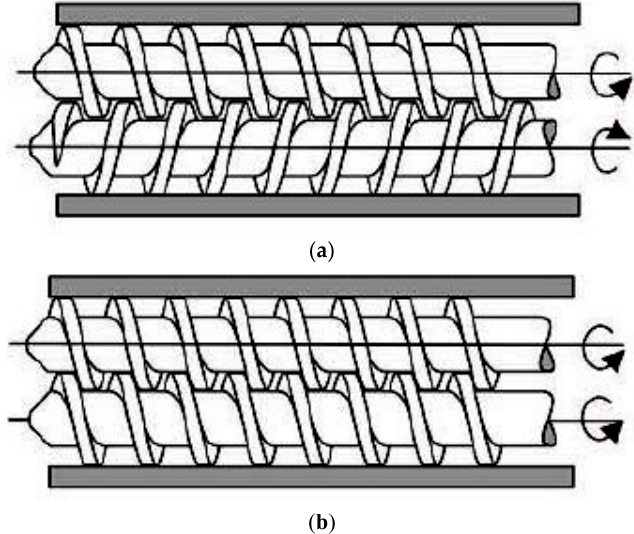
Figure 3. Twin-screw extruder barrel ( a ) Counter-rotating screws ( b ) Co-rotating screws (Reproduced with permission from reference [29], Scientific & Academic Publishing, 2016).